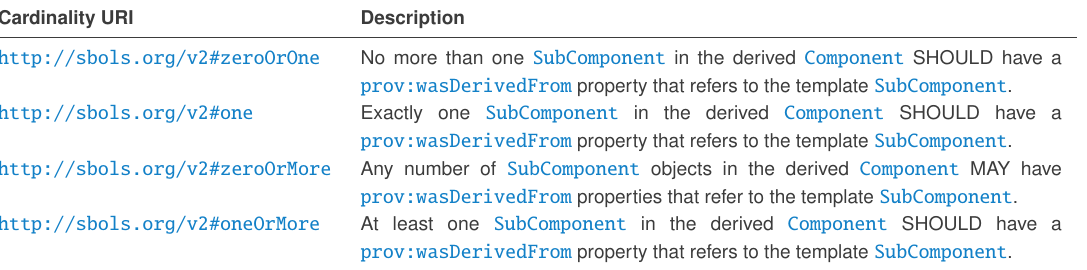
Table 13: REQUIRED URI s for the cardinality property.